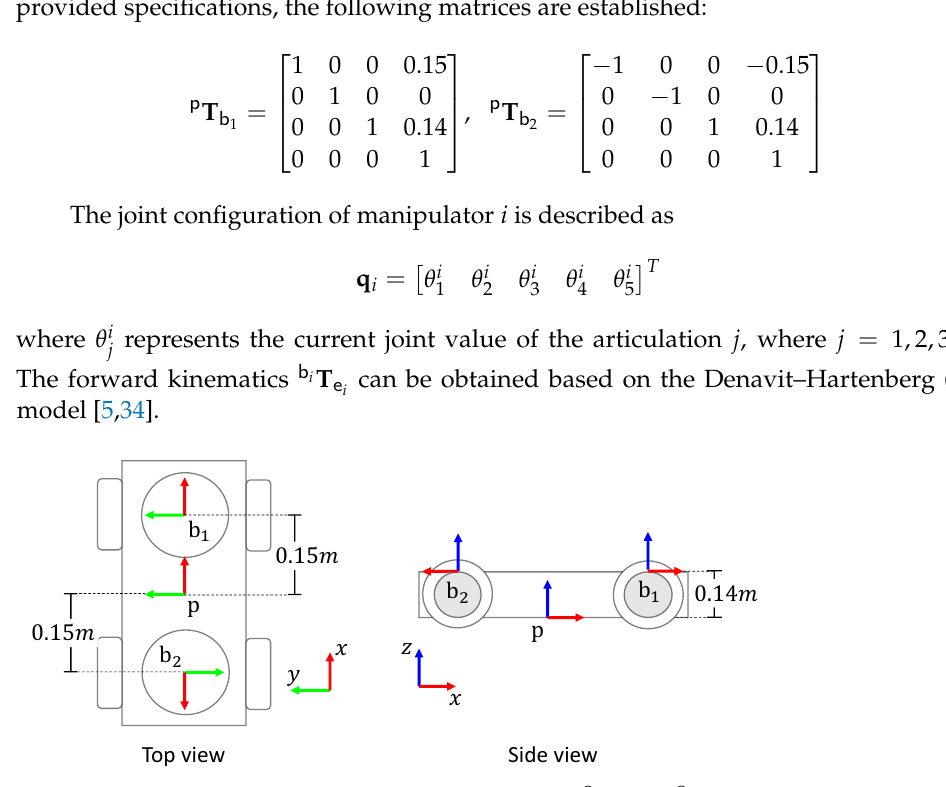
Figure 3. Coordinate frames assignment for the KUKA ® Youbot ® mobile platform based on the technical specifications